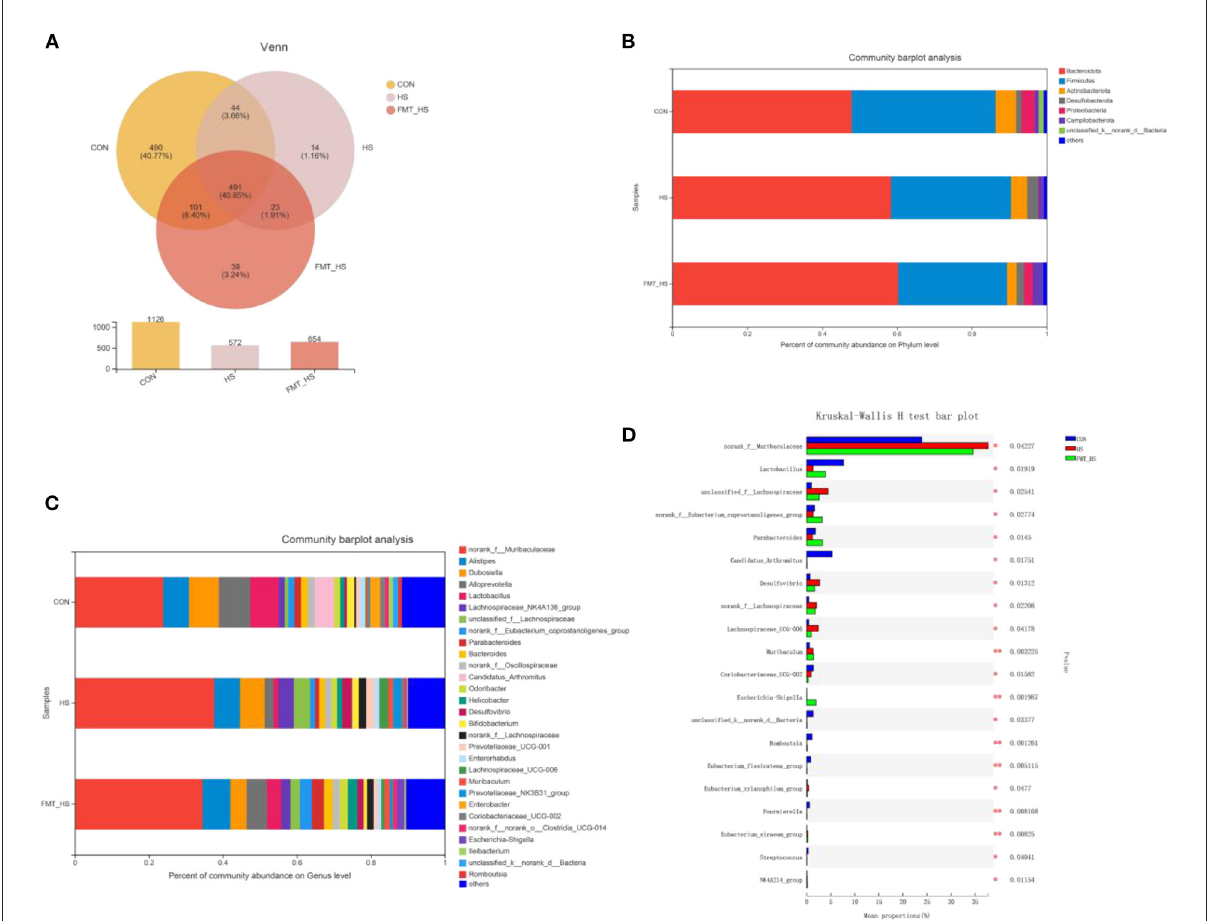
FIGURE3 High salt (HS) significantly changed gut microbiota composition, which was screened by fecal microbiota transplantation ( n = 6). The down-regulated OTU number is shown in here (A) . Phylum-level abundance as a percentage of total community abundance (B) . The top 30 in community abundance in terms of genera percent (C) . The significantly different genera (D) . Kruskal-Wallis test with Dunn post hoc test was used for statistical tests. * p < 0.05, ** p < 0.01, ** p <